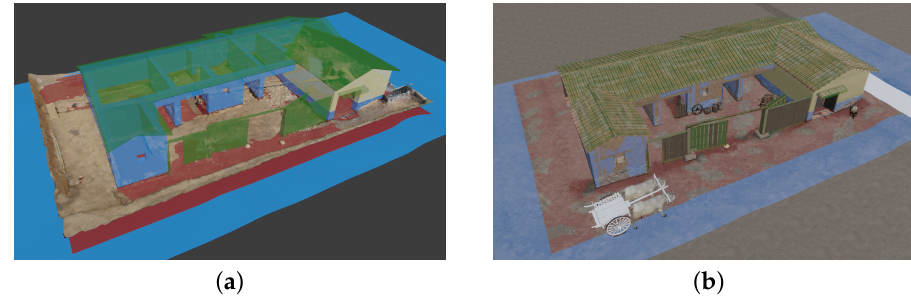
Figure 11. Superimposition of the Proxy model on the Digital Replica ( a ) and on the Representation model ( b ) in order to add the chronological and provenance information. See colour chart in Table 3.